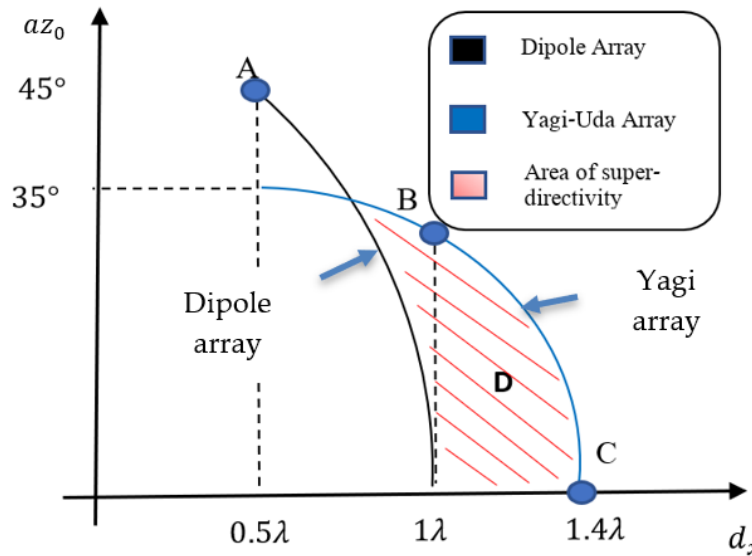
Figure 9. Element Array in X–Z plane; A—Dipole Array with d x = 0.5 λ ; B—Yagi-Uda array with d x = 1 λ ; C—Yagi-Uda array with d x = 1.4 λ ; D—The super-directivity domain.